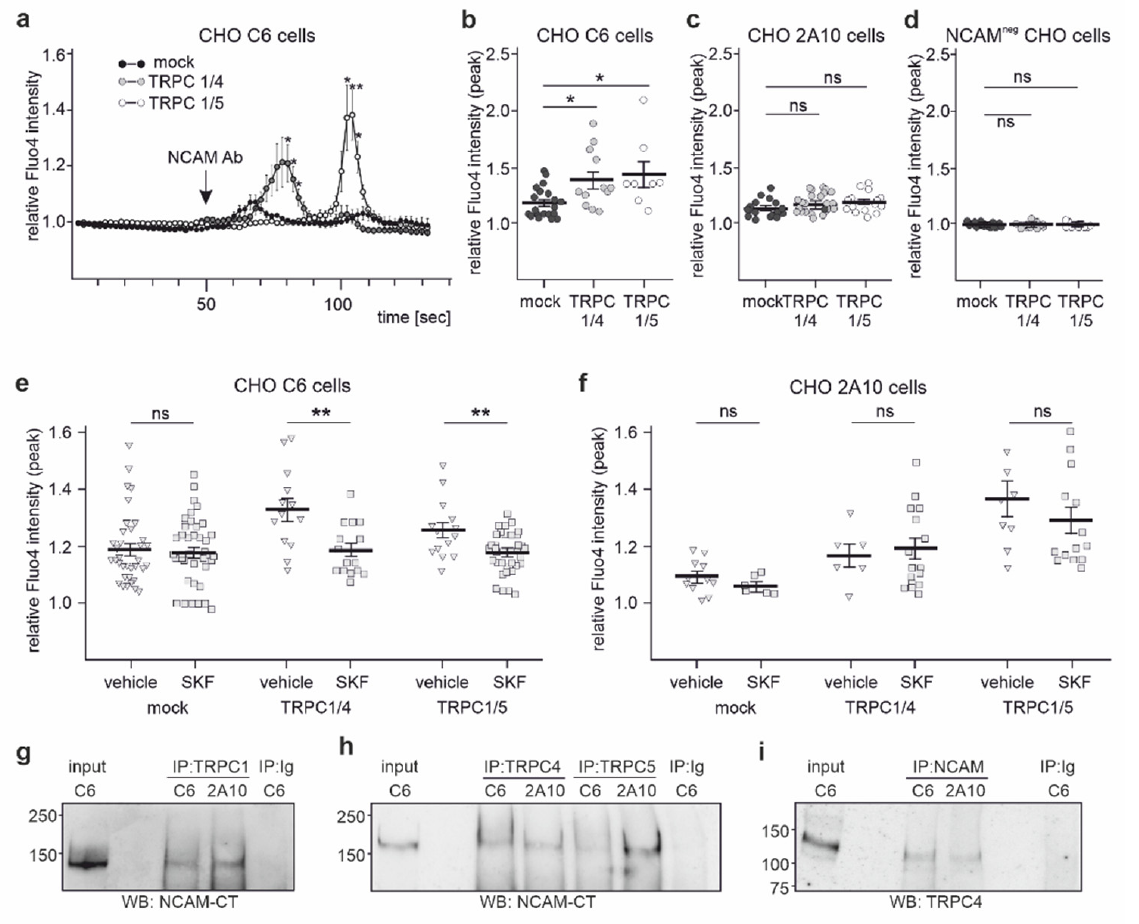
Figure 8. NCAM regulates the Ca 2+ entry via TRPC1, − 4, and − 5 in transfected CHO cells that ex- press PSA-NCAM. NCAM-expressing CHO 2A10 cells, PSA-NCAM-expressing CHO C6 cells, or